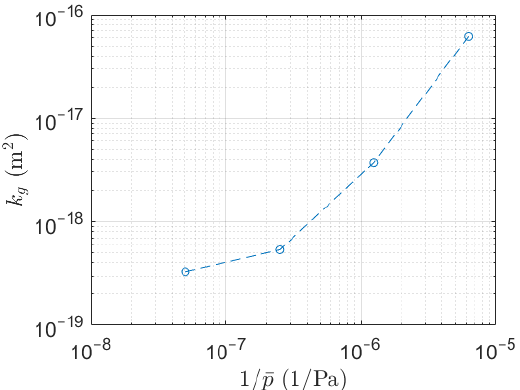
Figure 8. Apparent gas permeability of the shale sample versus inverse